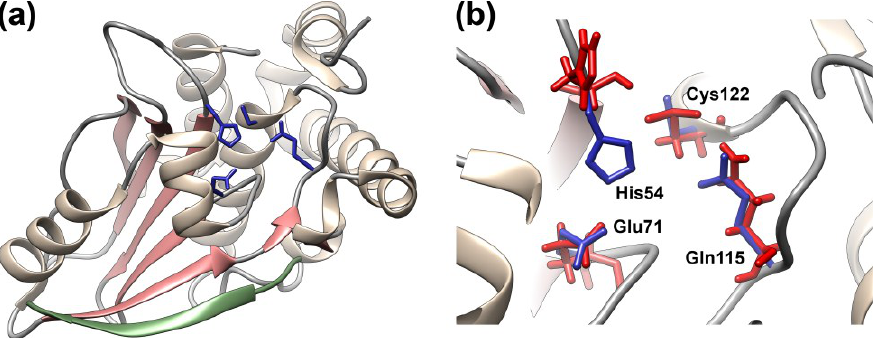
Figure 3. Crystal structure of the AVP-pVIc complex and locations of the four amino acid residues involved in catalysis in AVP and in AVP-pVIc. ( a ) Secondary structure of the AVP-pVIc complex with the four amino acid residues involved in catalysis in blue and the pVIc peptide in green; ( b ) The four amino acids involved in catalysis in AVP-pVIc (blue) and in AVP (red) are juxtaposed. Only His54 is in a different position in the two structures. Figure created with UCSF Chimera (http://www.cgl.ucsf.edu/chimera/)